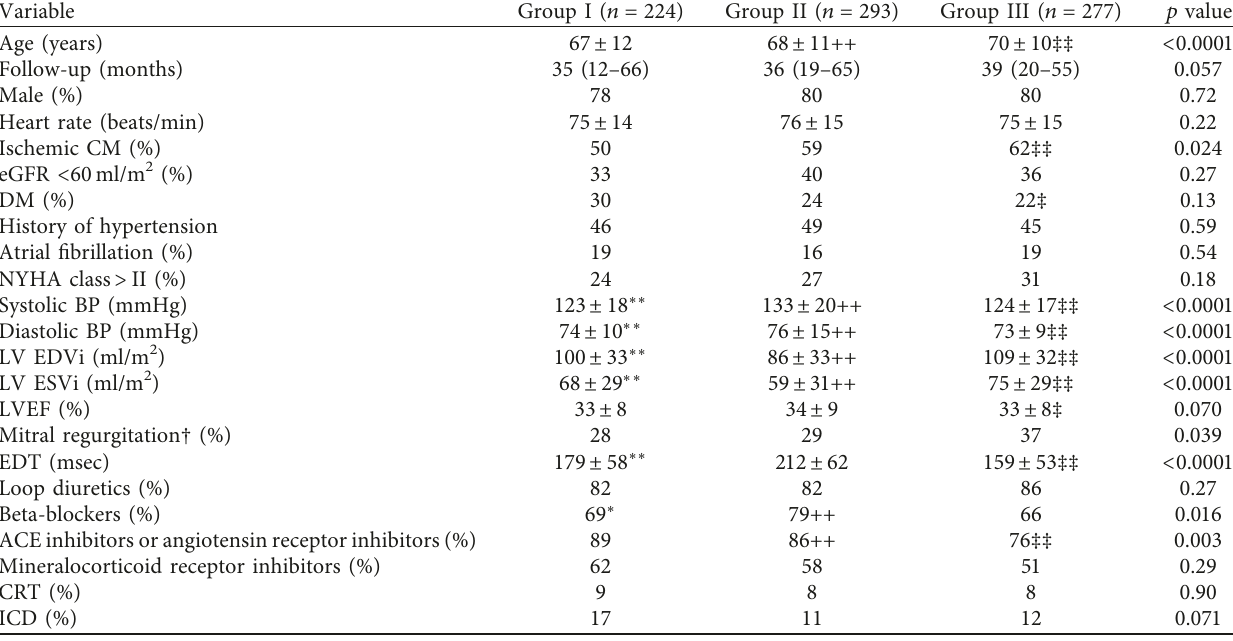
Table 1: Demographic, clinical, and echocardiographic baseline characteristics of the study groups.